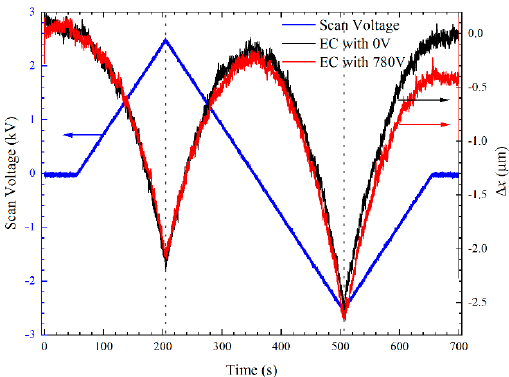
Figure 19. Wire voltage profile and the corresponding arm displacement.